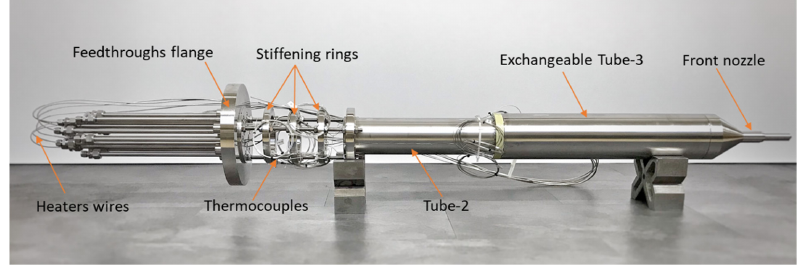
Figure 2. The first insert assembly featuring Tube-3 with smooth surface roughness.